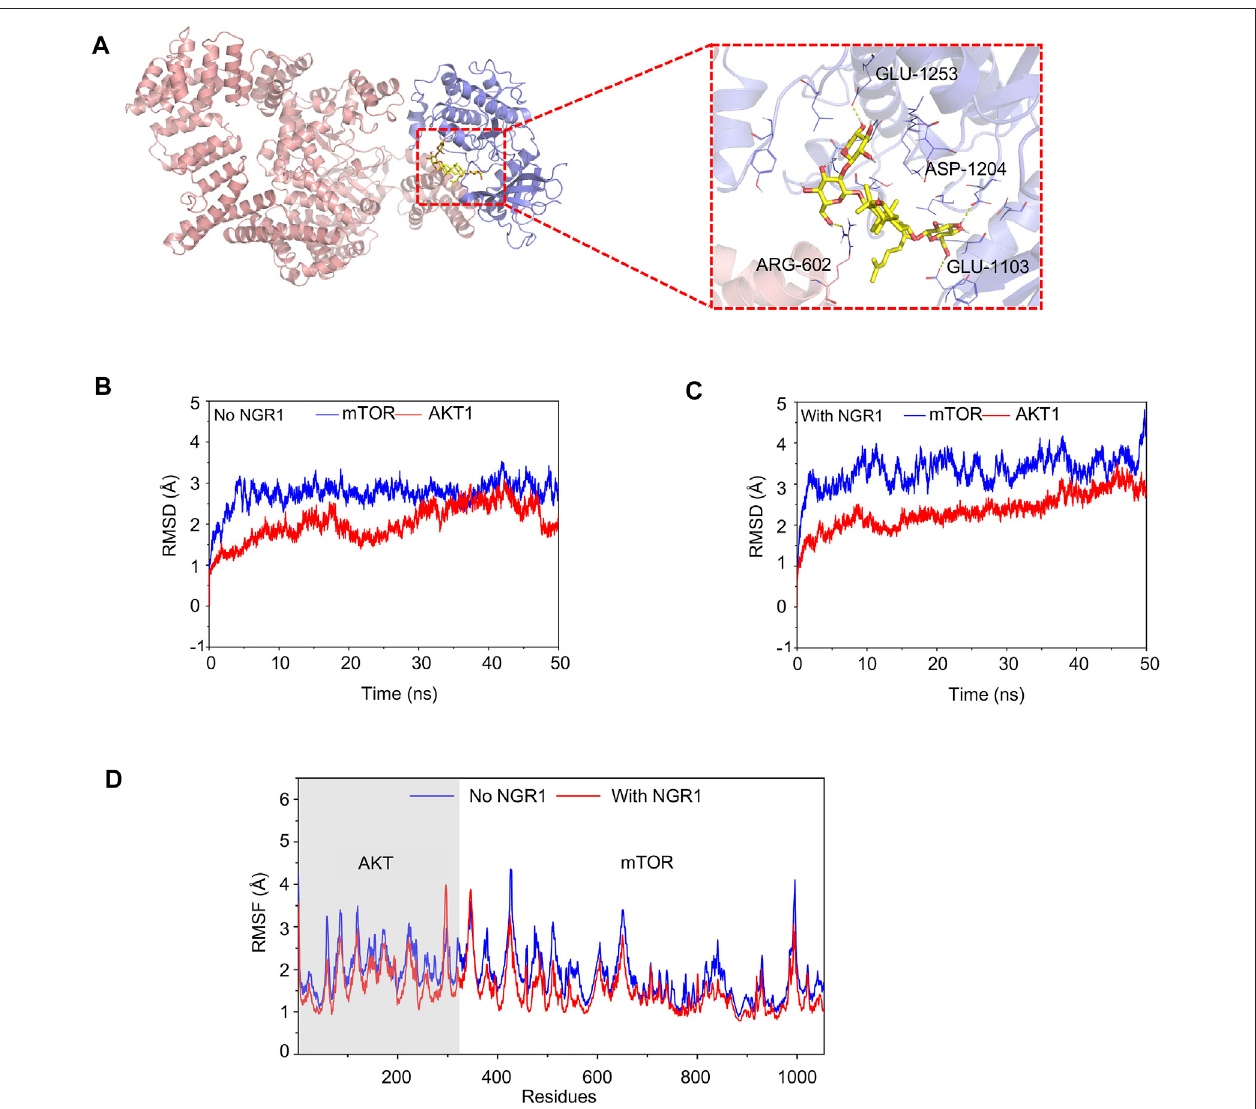
FIGURE 7 | Conventional MD simulation for evaluating the binding af fi nity of mTOR and AKT with or without NGR1. (A) Overview structure of the mTOR-AKT complex with NGR1 and a zoom-in view of NGR1 and the surrounding amino acids. (B) Backbone (alpha-C, C, N atoms) RMSDs are shown as a function of time for mTORandAKTwithoutNGR1during50-nsmoleculardynamicssimulation. (C) Backbone(alpha-C,C,andNatoms)RMSDsareshownasafunctionoftimeformTOR and AKT with NGR1 during 50-ns molecular dynamics simulation. (D) RMSF of mTOR and AKT residues in 50-ns molecular dynamics simulation.